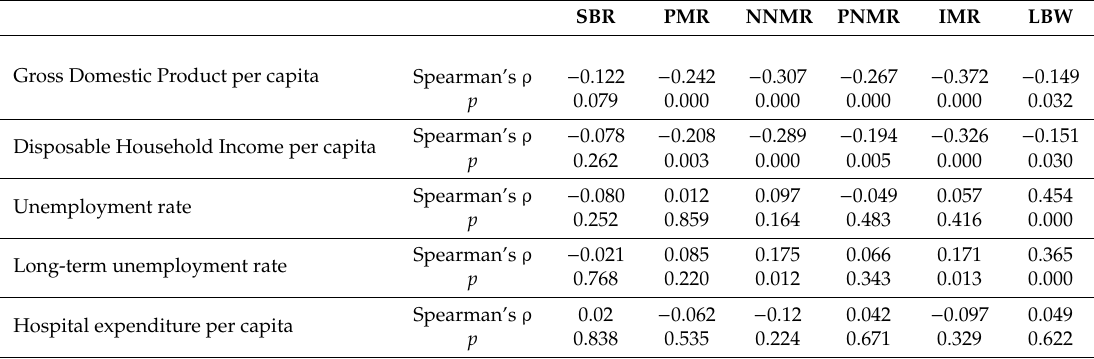
Table 3. Spearman’s ρ correlation coe ffi cient and p -value of the correlation between perinatal and infant mortality indicators and socioeconomic variables.